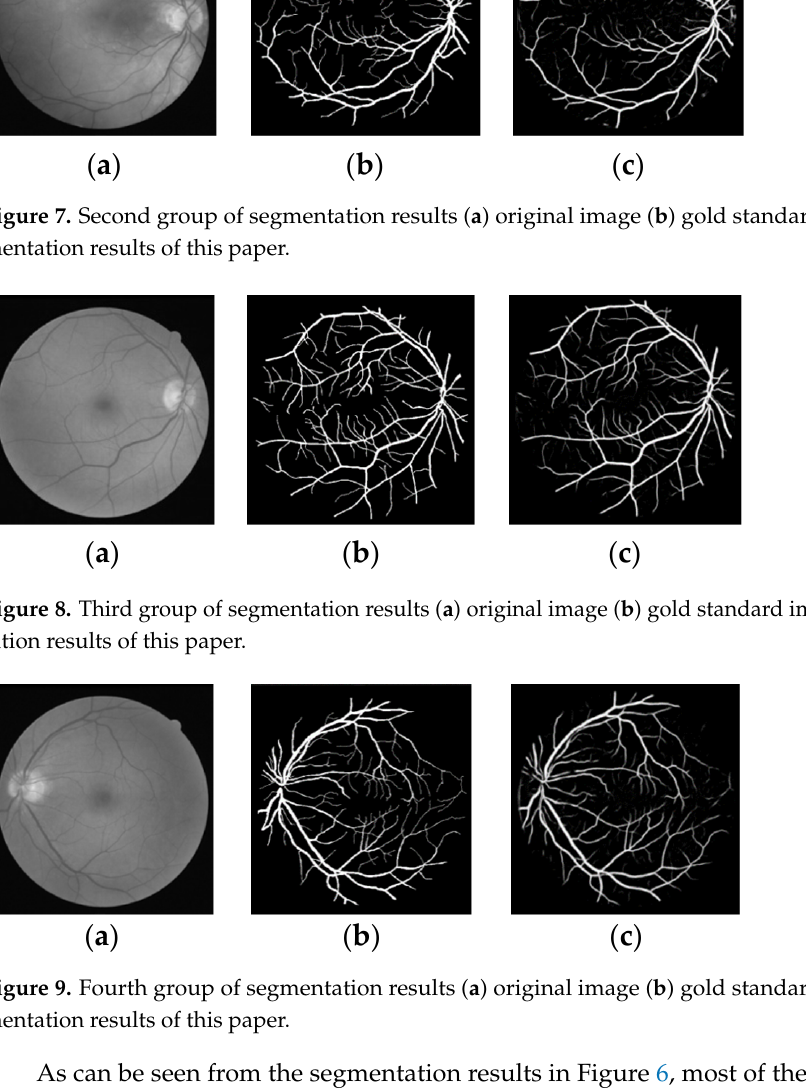
Figure 9. Fourth group of segmentation results ( a ) original image ( b ) gold standard image ( c ) seg- mentation results of this paper.